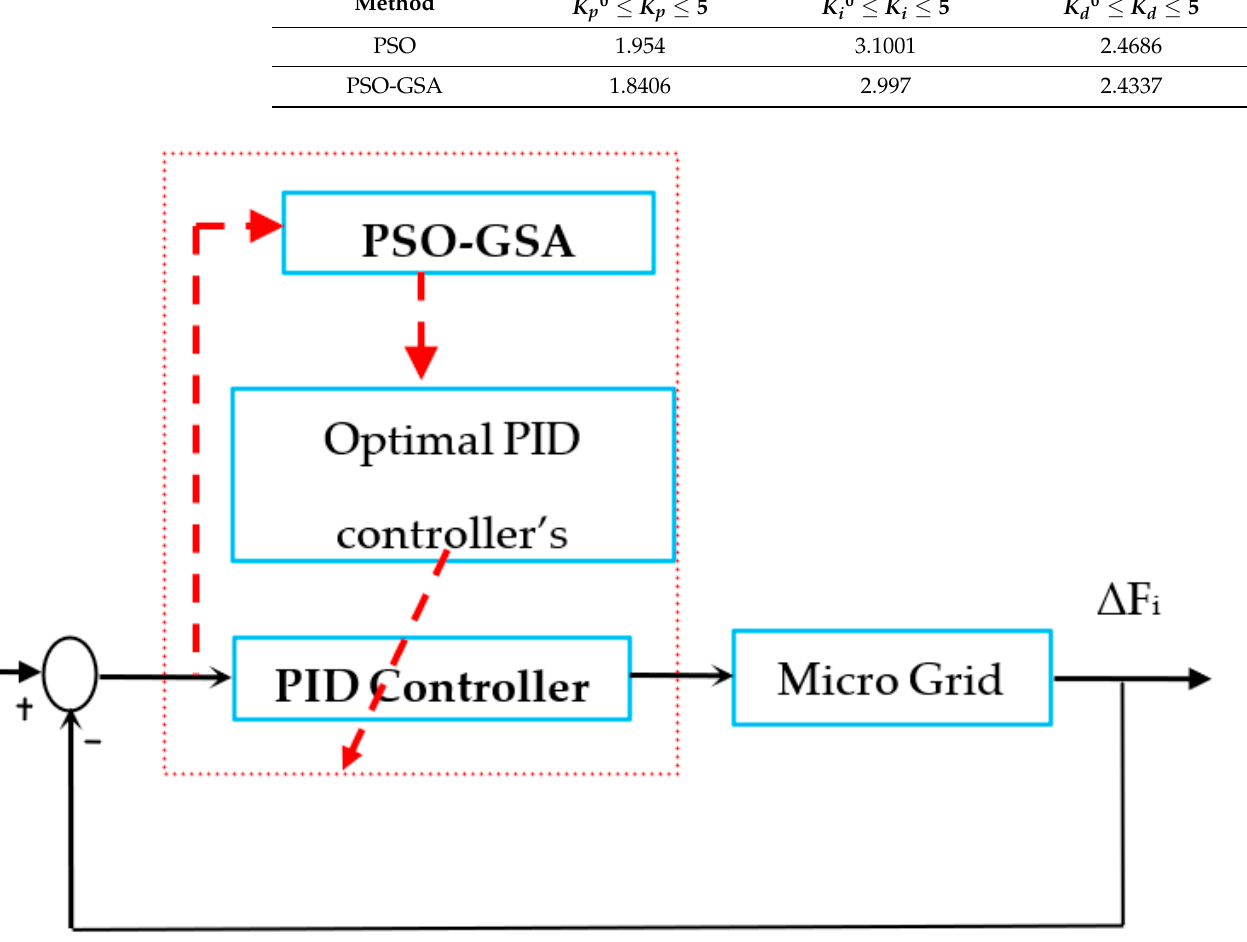
Figure 4. Proposed algorithm on the system under study.